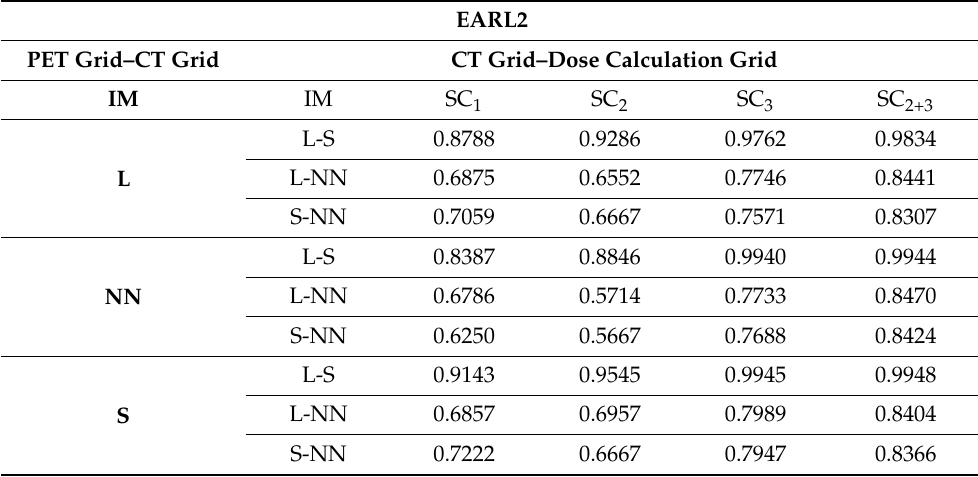
Table 4. Shape coefficients obtained for the EARL2 reconstruction when going from the CT grid to the dose calculation grid.